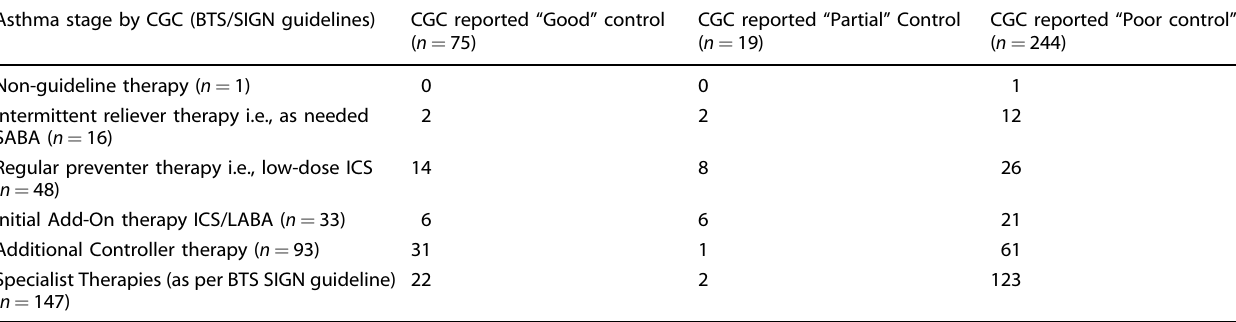
Table 1. Asthma control at each BTS/SIGN therapy